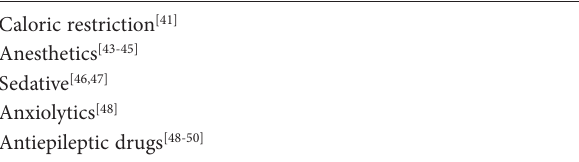
Table 2. Drugs decreasing entropy production.